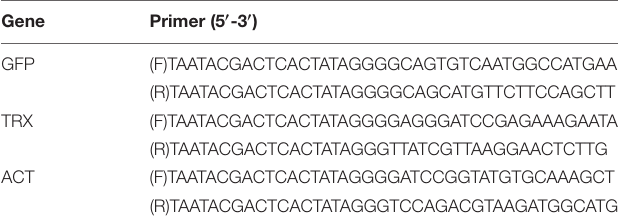
TABLE 1 | The primer sets used for dsRNA synthesis.